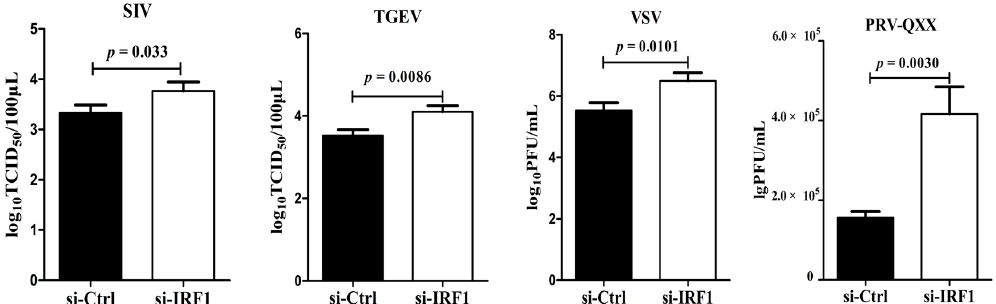
Figure 3. Knockdown of poIRF1 promotes moderately virus replication. ( A ) The knockdown efficiency of poIRF1 was determined by RT-qPCR. PK-15 cells were transfected with si-IRF1 or si-Ctrl for 24 h, 36 h and 48 h, and subsequently the poIRF1 expression in transfected cells was verified at mRNA levels by RT-qPCR; ( B ) The knockdown efficiency of poIRF1 was checked by Western blot. PK-15, PK-15/PB and PK-15/IRF1 cells were transfected with si-IRF1 or si-Ctrl for 36 h. The poIRF1 expression in transfected cells was verified at protein levels by Western blot assay. β -actin was used as a loading control; ( C ) The effect of knockdown of poIRF1 on viral replication. PK-15 cells were transfected with si-IRF1 or si-Ctrl for 36 h. Then, cells were incubated with indicated viruses for 24 h